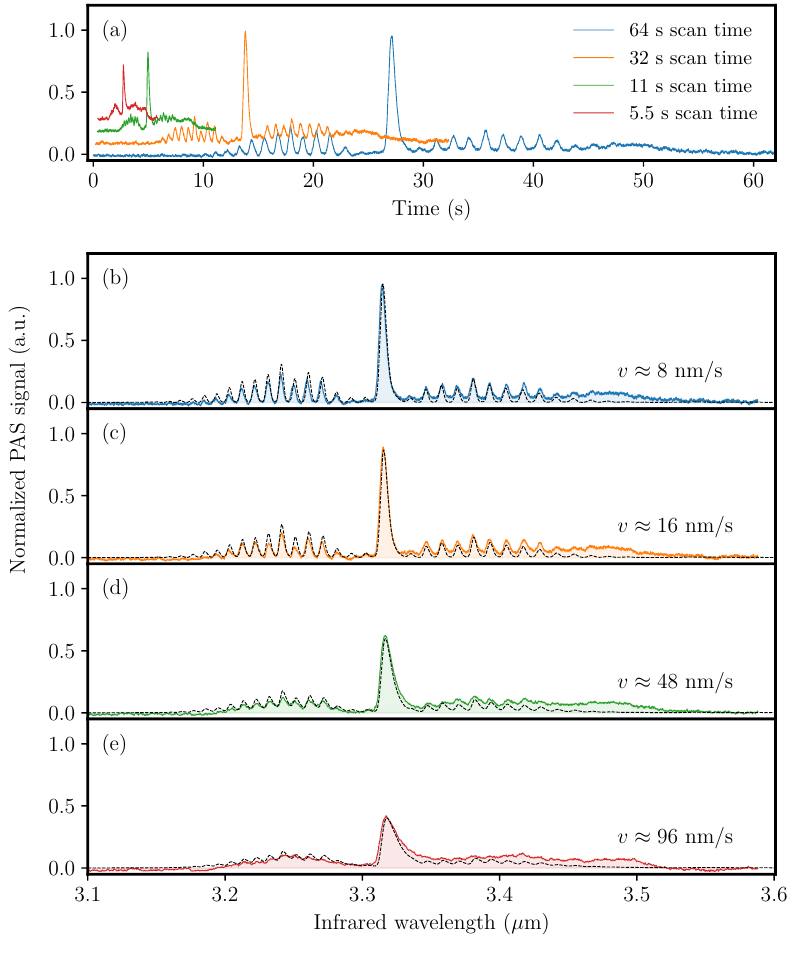
Figure 6. Acquired photoacoustic signal for 100 ppmV CH 4 in an N 2 -matrix. ( a ) Photoacoustic signal versus time showing the relative time scales of the four stepper-motor speeds of 8 nm s − 1 , 16 nm s − 1 , 48 nm s − 1 , and 96 nm s − 1 . ( b – e ) Same data (color coded) as in ( a ), but plotted with respect to wavelength rather than time. For reference purposes, the black dashed lines represent Hitran absorption data for CH 4 using appropriate instrumental profiles as explained in the